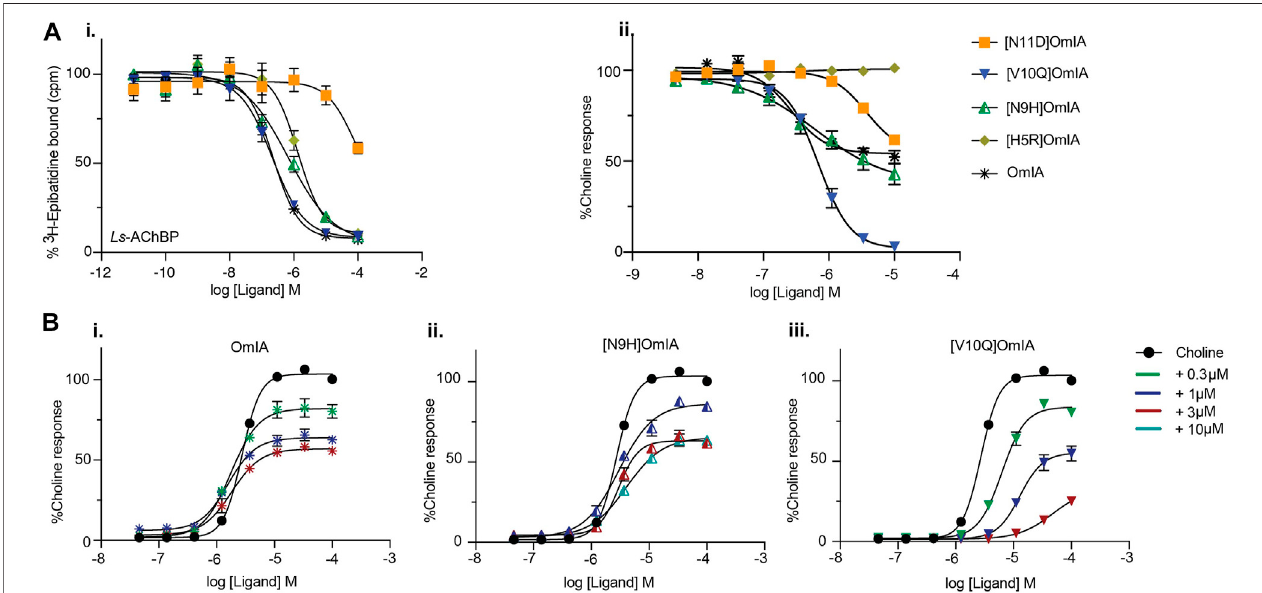
FIGURE3| ActivityofOmIAanditsanaloguesonLs-AChBP (A) and α 7nAChRswiththeadditionofnAChRtypeIIPAMPNU120596 (B) . (A) Displacementof( 3 H)- epibatidine from Ls -AChBP (i) and the inhibition of choline activation of α 7 nAChRs measured in a FLIPR Ca 2+ in fl ux assay on SH-SY5Y cells with the addition of nAChR type II PAM PNU-120596 (ii) by OmIA and its analogues. (B) Concentration-response curves for choline alone (black round) and in the presence of increasing concentrations of OmIA (i), [N9H]OmIA (ii), and [V10Q]OmIA (iii). Data represent mean ± SEM of triplicate data from three independent experiments.